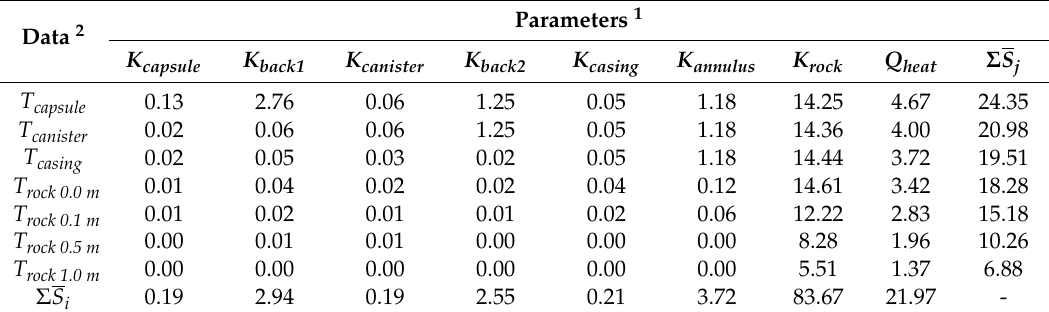
Table 2. Scaled sensitivity coefficients S ij and composite sensitivity